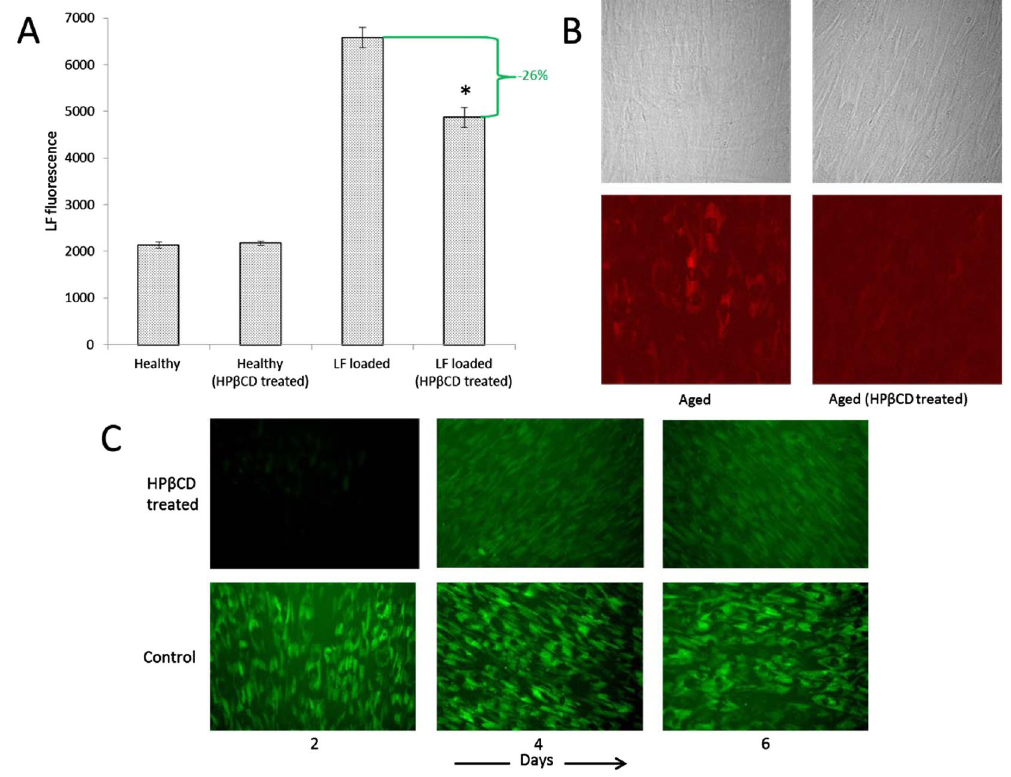
Figure 1. HP β CD reduces LF and lipopigment. ( A ) Exposure of skin fibroblasts to oxidizing conditions for 10 days loads cells with LF. HP β CD addition on days 5–10 reduces LF totals by 26%. Asterisk ( * ) indicates statistically significant reduction ( p < 0.001, N = 4). ( B ) Serial passaged fibroblasts accumulate LF (left column). HP β CD treatment significantly reduces LF accumulation (right column). Light microscopy (top row) and LF imaging (bottom row) ( C ) HP β CD slows lipopigment accumulation. Healthy human skin fibroblasts were exposed to oxidizing conditions for 8 continuous days in the presence and absence of HP β